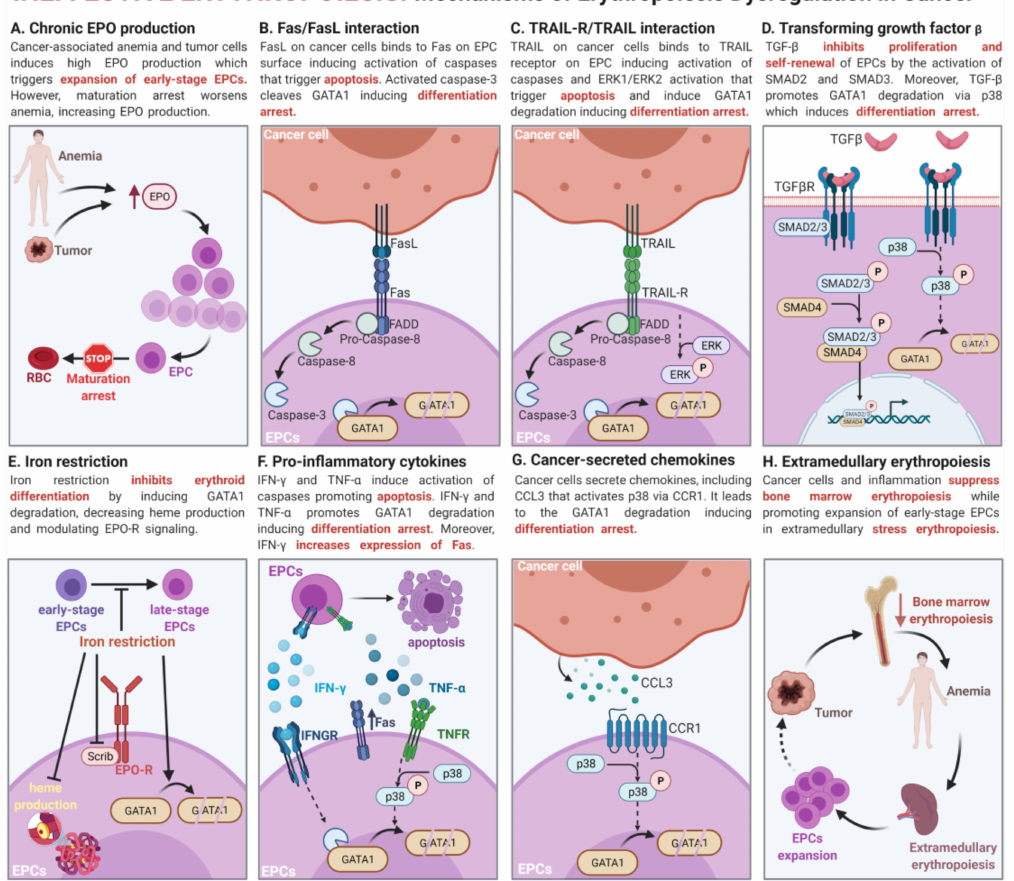
Figure 2. Mechanisms of erythropoiesis dysregulation in cancer. Expansion of early-stage EPCs is caused by ( A ) chronic erythropoietin (EPO) production. However, EPCs are unable to generate mature red blood cells (RBCs) due to increased apoptosis and differentiation arrest. EPCs apoptosis is triggered by ( B ) FasL/Fas and ( C ) TRAIL-TRAIL-R interaction between EPCs and cancer cells. Differentiation arrest of early-stage EPCs is caused by ( D ) transforming growth factor β (TGF- β ), ( E ) iron restriction, ( F ) pro-inflammatory cytokines, and ( G ) cancer-secreted chemokines. Inhibited maturation is an effect of GATA1 degradation mediated by caspase-3 or p38 activation. ( H ) Bone marrow steady-state erythropoiesis is suppressed by inflammation and triggers stress erythropoiesis and expansion of EPCs in extramedullary